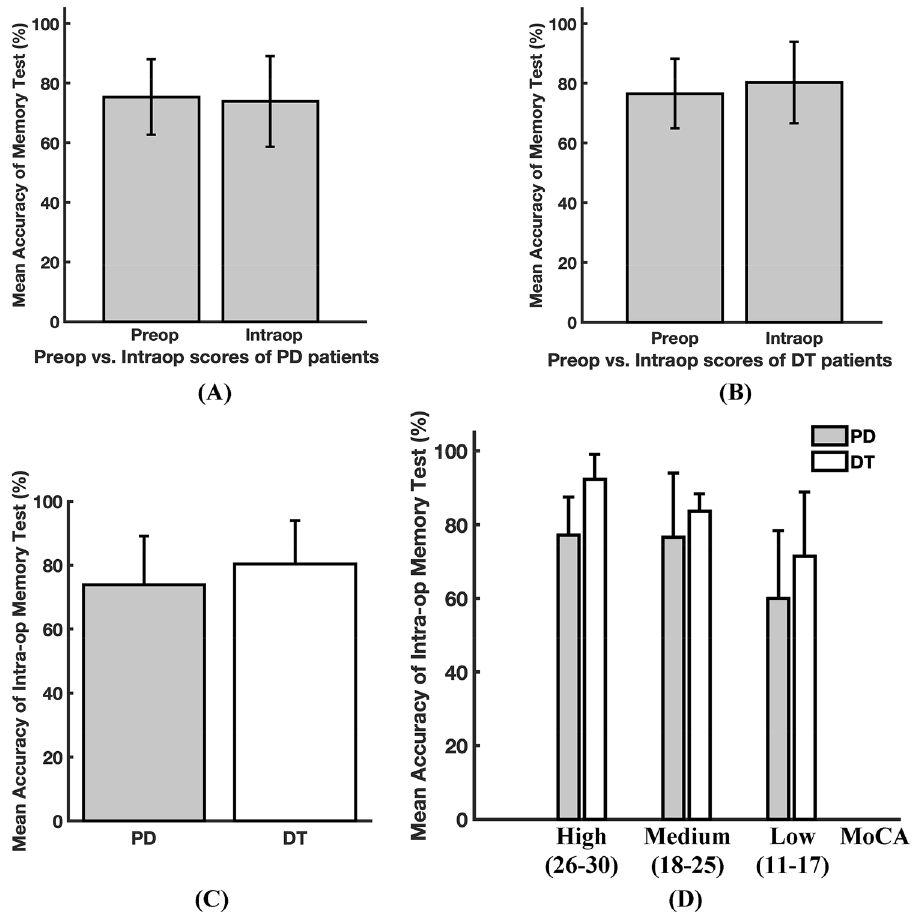
Figure 3. Comparison of the intraoperative memory test scores between the PD and DT patients. ( A ) Comparison of the preoperative and intraoperative memory test scores in the PD patients. ( B ) Comparison of the preoperative and intraoperative memory test scores in the DT patients. ( C ) Comparison of the intraoperative memory test scores between the PD and DT patients. ( D ) Comparison of the intraoperative memory test scores between the PD and DT patients in cognitive impairment subgroups as defined by the MoCA scores 27,28 . PD Parkinson’s disease, DT dystonia, MoCA Montreal Cognitive